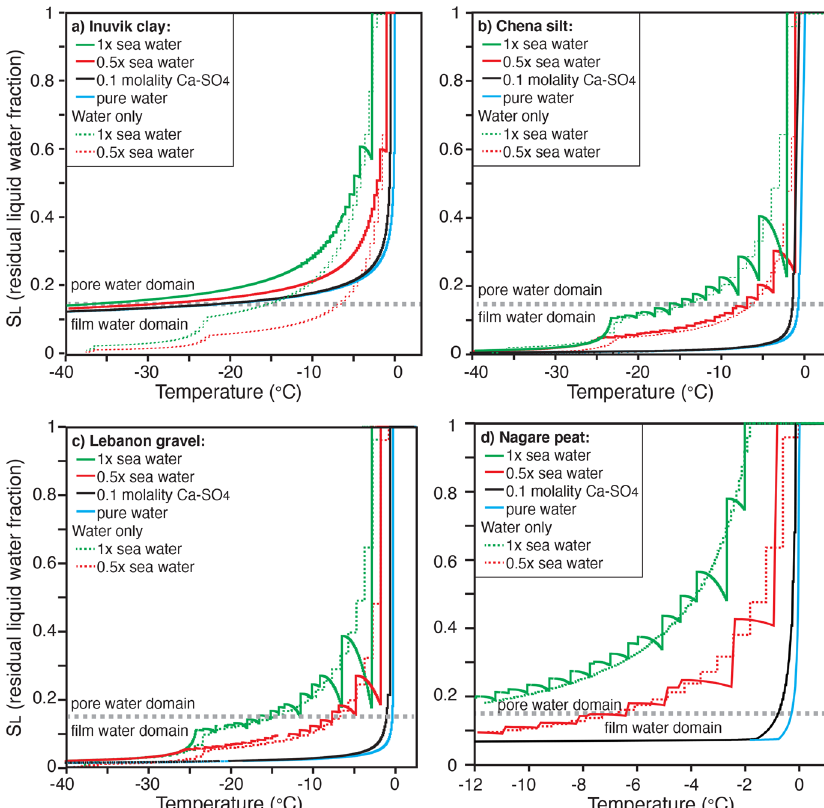
Fig. 3 Unfrozen water content pro fi les for various sediment types with varying soil water chemistry. The S L pro fi les were computed using SOIL8MIN model 28 . a Inuvik clay, b Chena silt, c Lebanon gravel and d Nagare peat. The oscillations in the S L curves are due to an instability in the use of the Rempel- type equation to determine the fraction of residual liquid water that would force the ground ice to completely melt, but SOIL8MIN limits the amount of ground ice that can melt based on a heat energy exchange (see eq. 12 in Fisher et al. 2020). The pore water (S L > ~0.13) and fi lm water (S L < ~0.13) domains are illustrated as these determine the dominant process (REGO or VdW, respectively) by which the unfrozen water can